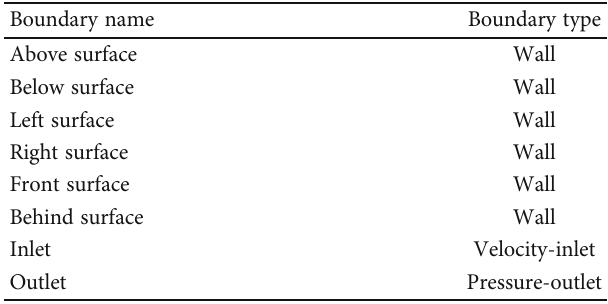
Figure 4: Meshing diagram in ICEM. Table 2: Model boundary parameters.